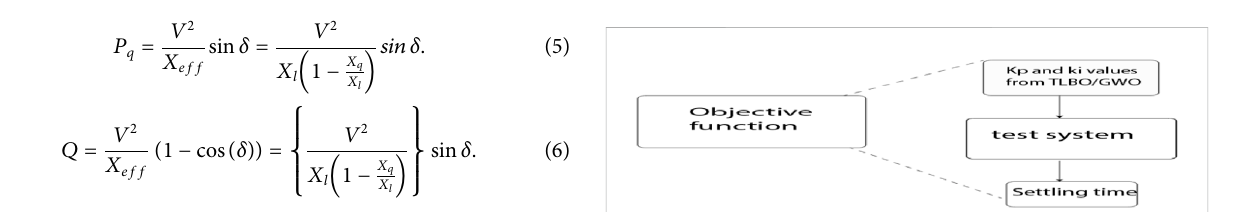
FIGURE 4 Operational diagram for tuning the